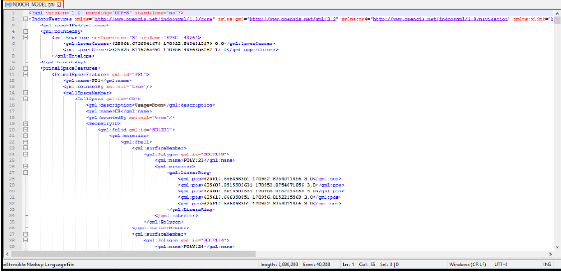
Figure 15 . XML schema of indoor spatial information.